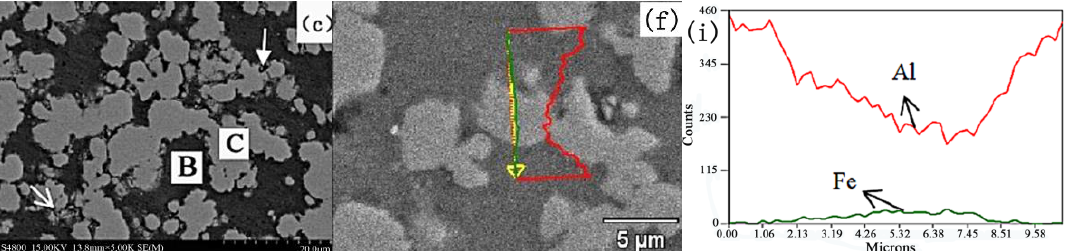
Figure 5. DSC tests of the Fe/Al composites with different maximum sintering temperatures. ( a , d , g ) 520 °C, ( b , e , h ) 550 °C, and ( c , f , i ) 600 °C.